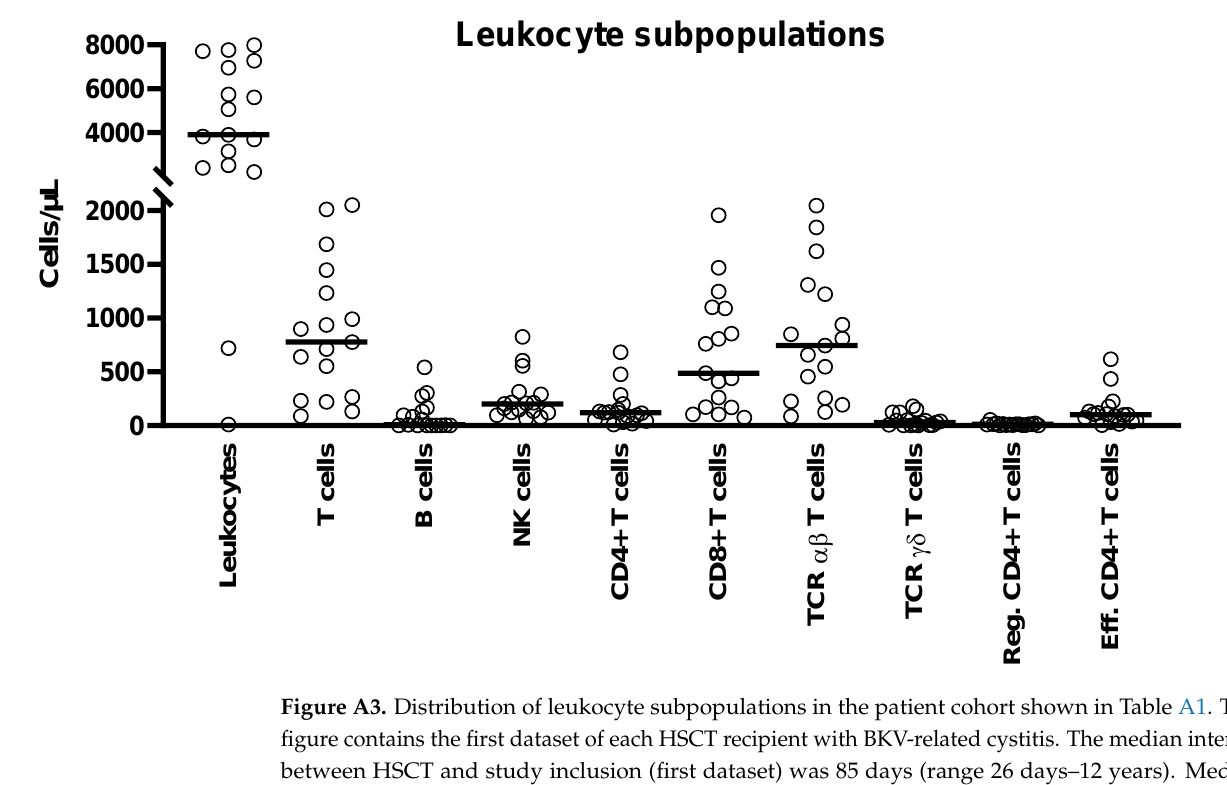
figure contains the first dataset of each HSCT recipient with BKV-related cystitis. The median interval between HSCT and study inclusion (first dataset) was 85 days (range 26 days–12 years). Median values are indicated by horizontal lines. Reg.—regulatory, Eff.—effector.